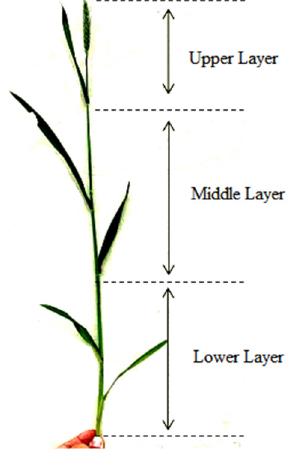
Figure 1. Schematic diagram of wheat